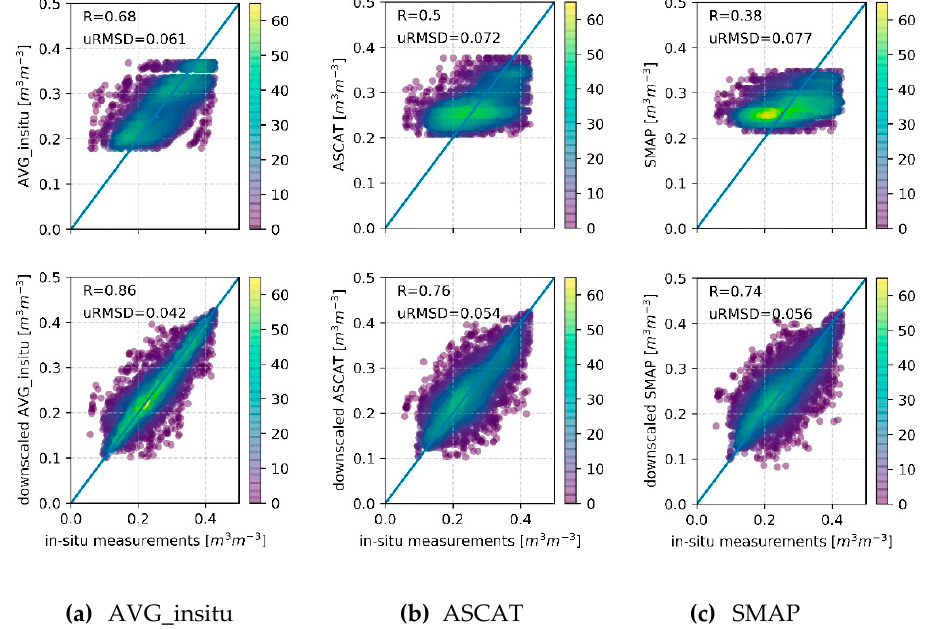
Figure 6. Scatterplots between measured soil moisture and original coarse-scale SSM products (top) and between measured and predicted soil moisture (model combination SSM + S + T + V) (bottom). The color indicates the number of observations. In each graph, the Pearson R and uRMSD are given. ( a ) AVG_insitu, ( b ) ASCAT, ( c ) SMAP.